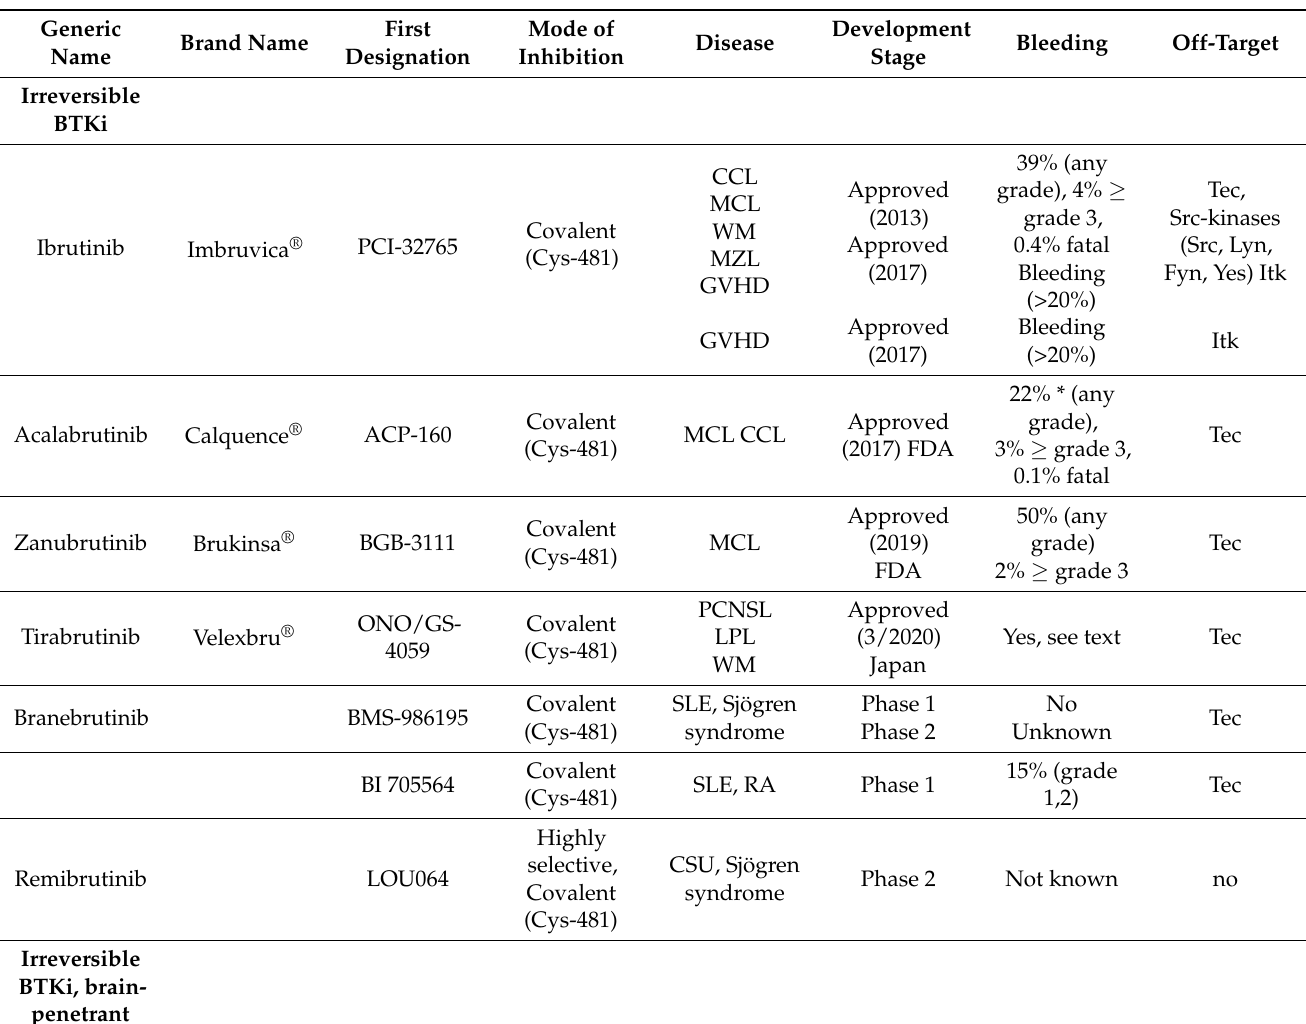
Table 1. Bruton-tyrosine kinase inhibitors (BTKi) approved or in clinical trials. Mode of inhibition, targeted disease, bleeding side effects, and platelet-relevant off-target kinase